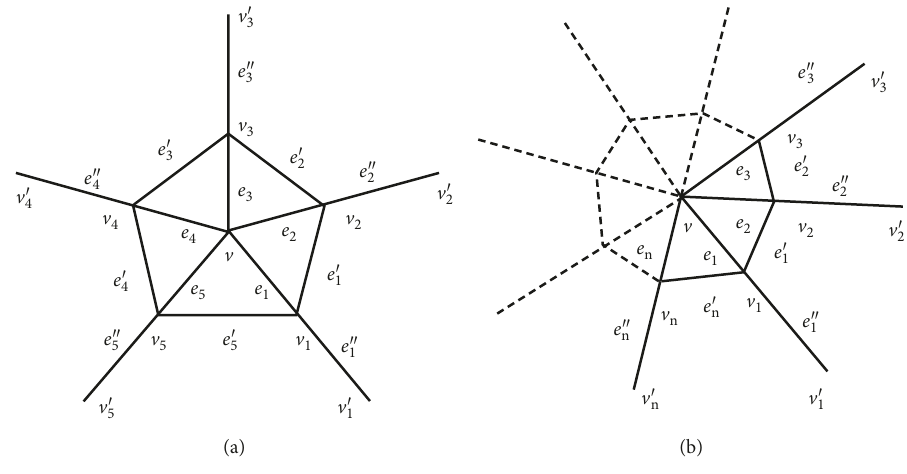
Figure 2: Helm graph ( H